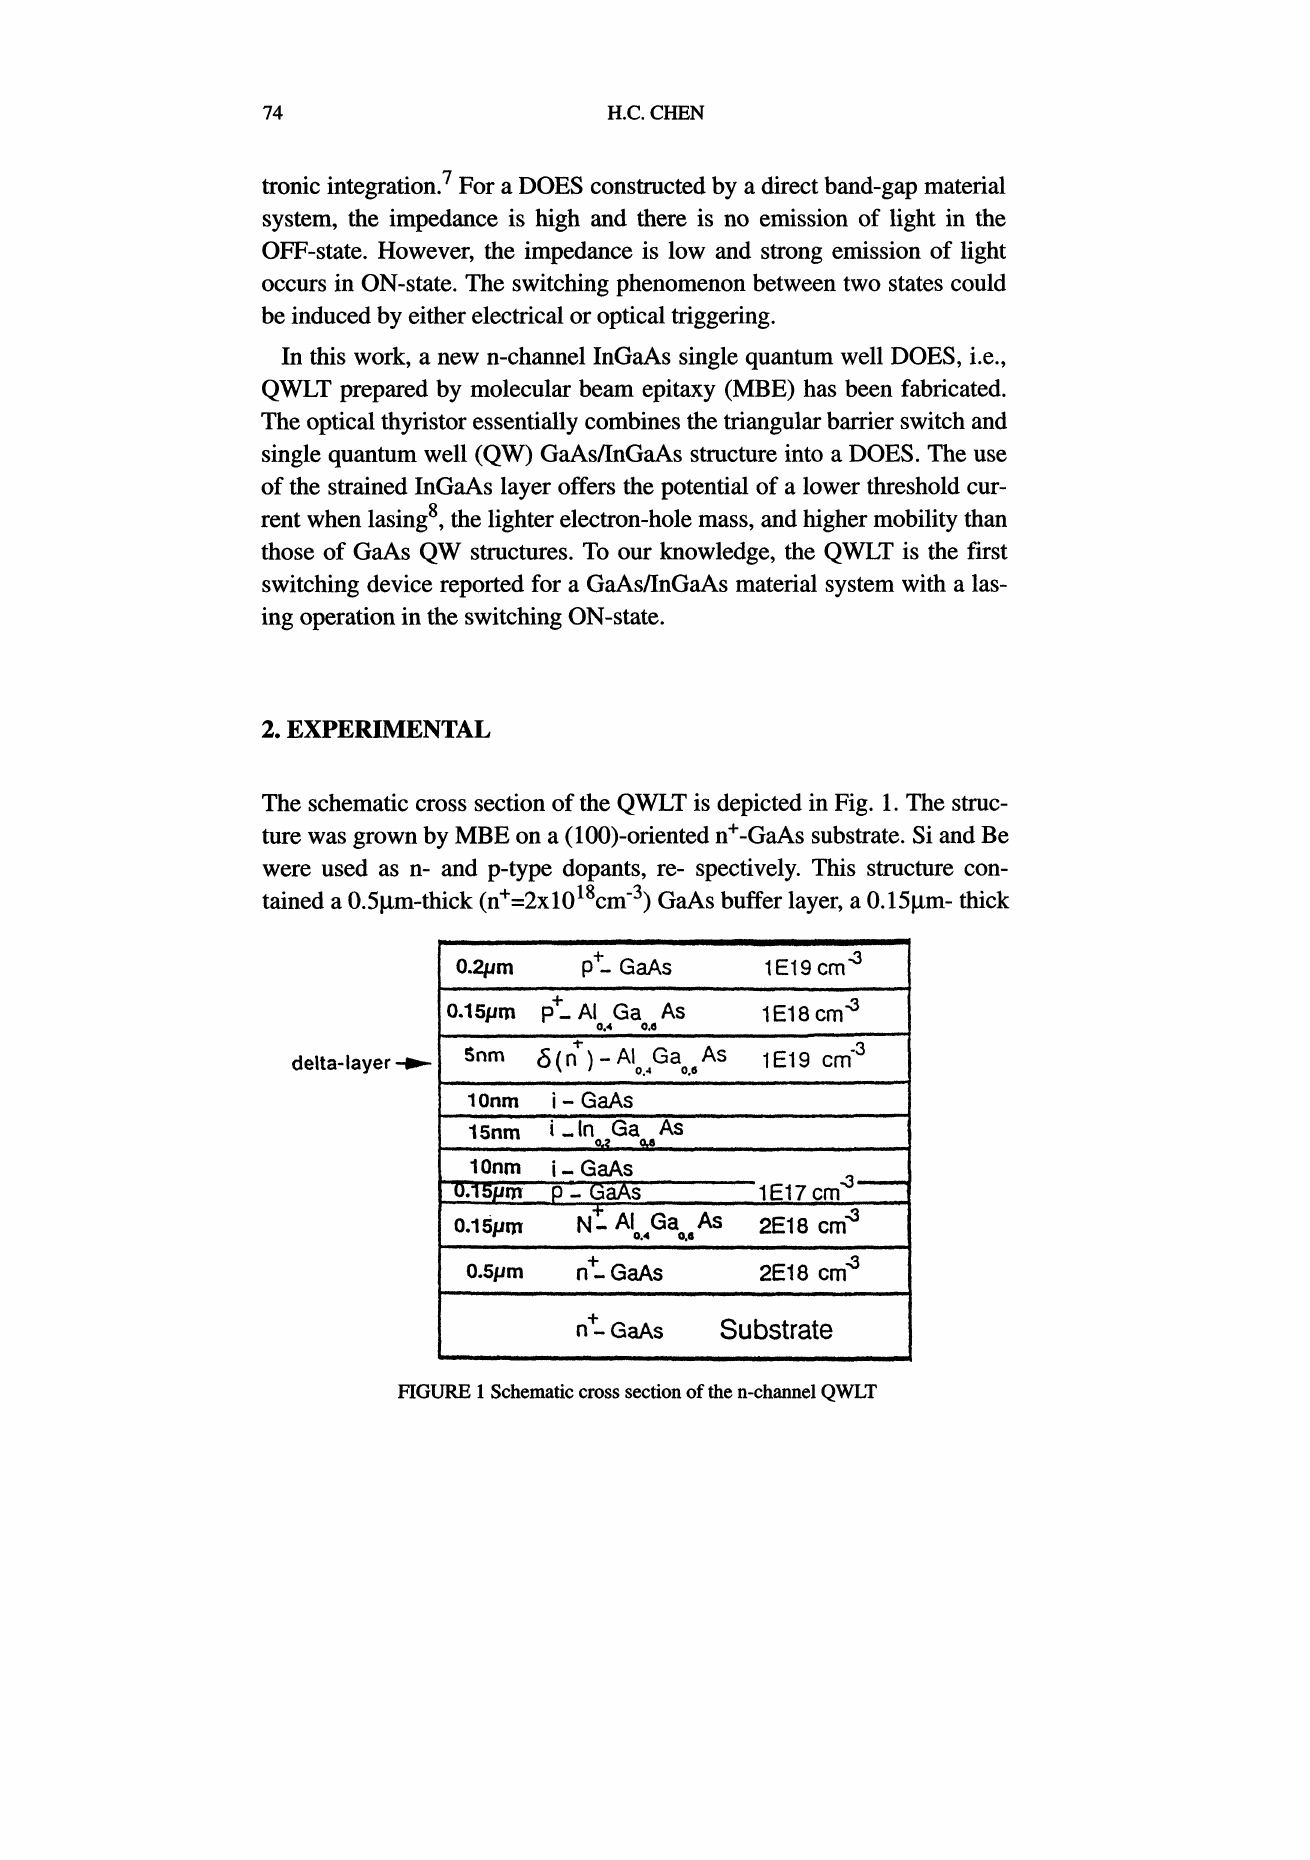
FIGURE Schematic cross section ofthe n-channel